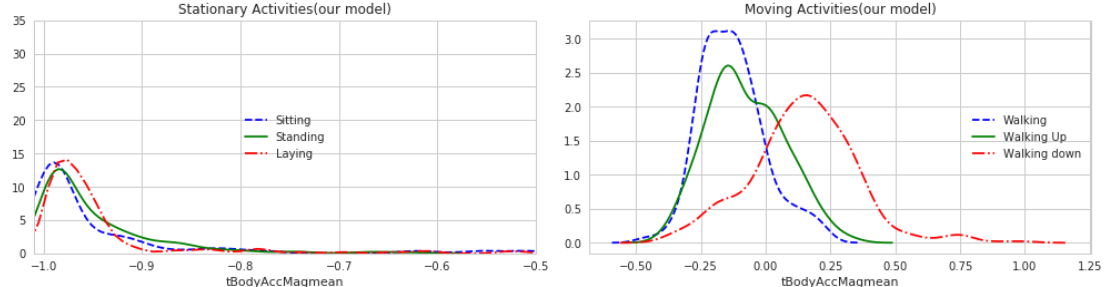
Figure 6. Curve of acceleration change (after preprocessing).